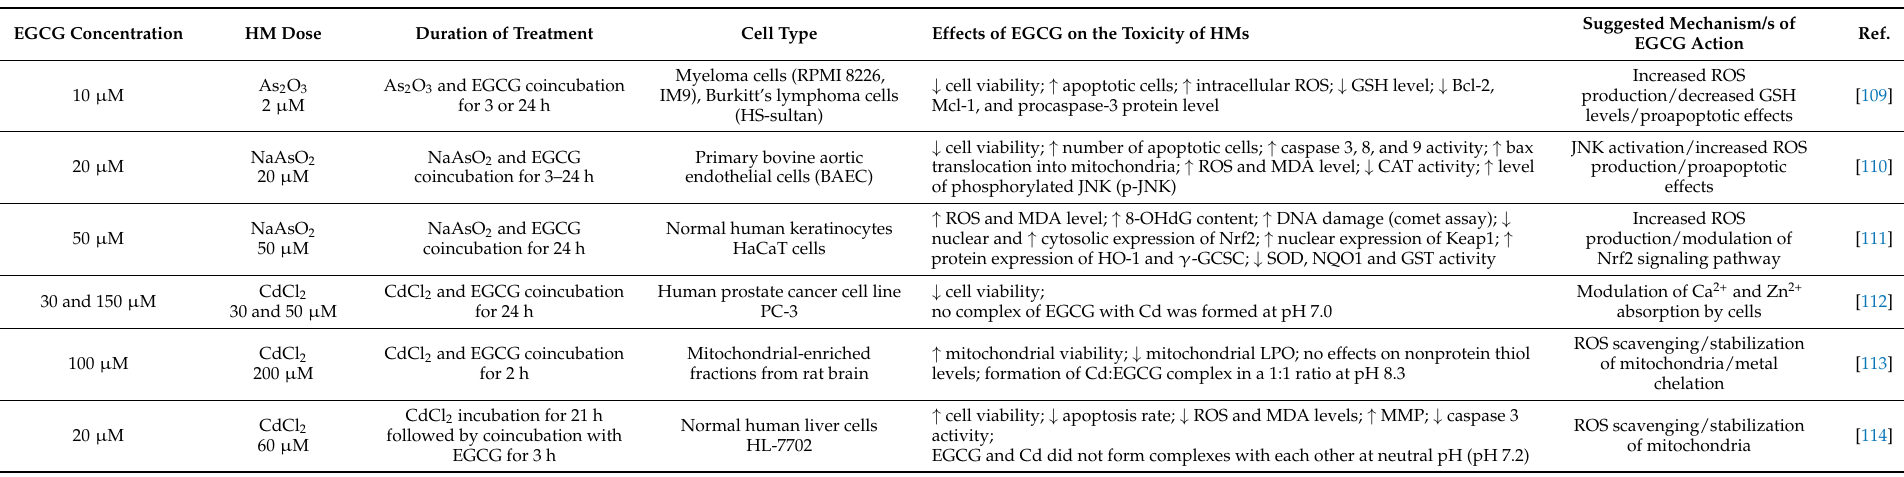
Table 3. Summary of studies evaluating EGCG effects on HM-induced toxicity in cell culture